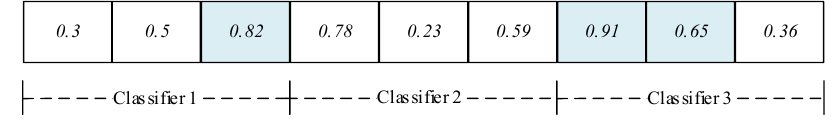
Figure 2. Individual representation.